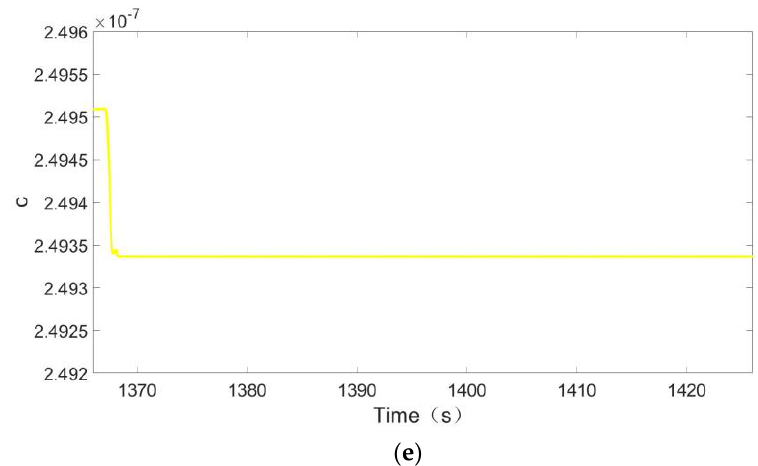
Figure 8. Simulation results of the fusion-based MCPE and the VD-based MCPE under normal driving conditions: ( a ) represents road with speed bumps. ( b ) represents road without speed bumps. ( c ) represents a brake event of 30bar. ( d ) and ( e ) represent the vehicle stops at a traffic intersection.